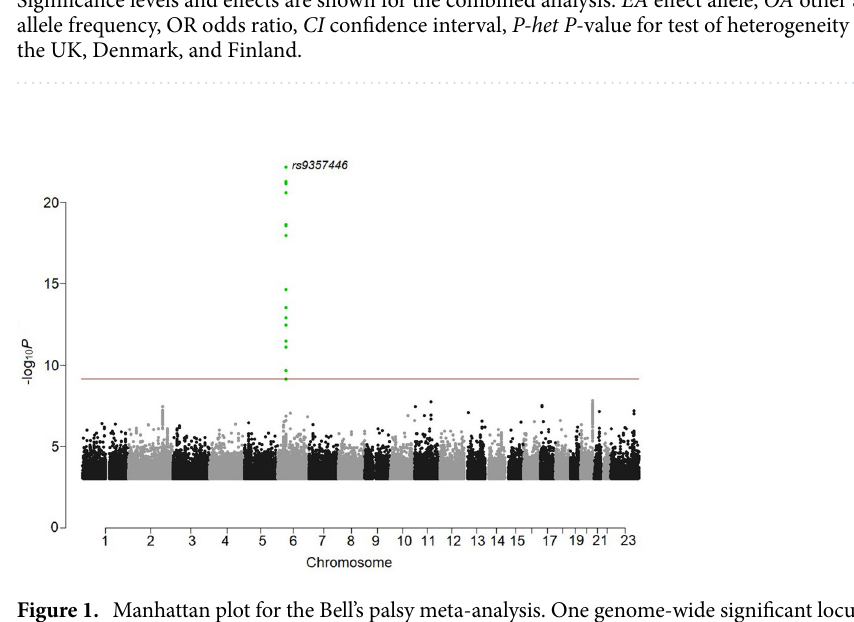
Figure 1. Manhattan plot for the Bell’s palsy meta-analysis. One genome-wide significant locus was detected. The − log 10 P- values (y-axis) are plotted for each variant against their chromosomal position (x-axis). The red line denotes the significance threshold for intergenic variants, P ≤ 7.4 × 10 –10 . P -values are two sided and derived from a likelihood ratio test (Methods). Individual Manhattan plots for each dataset are shown in Supplementary Fig.